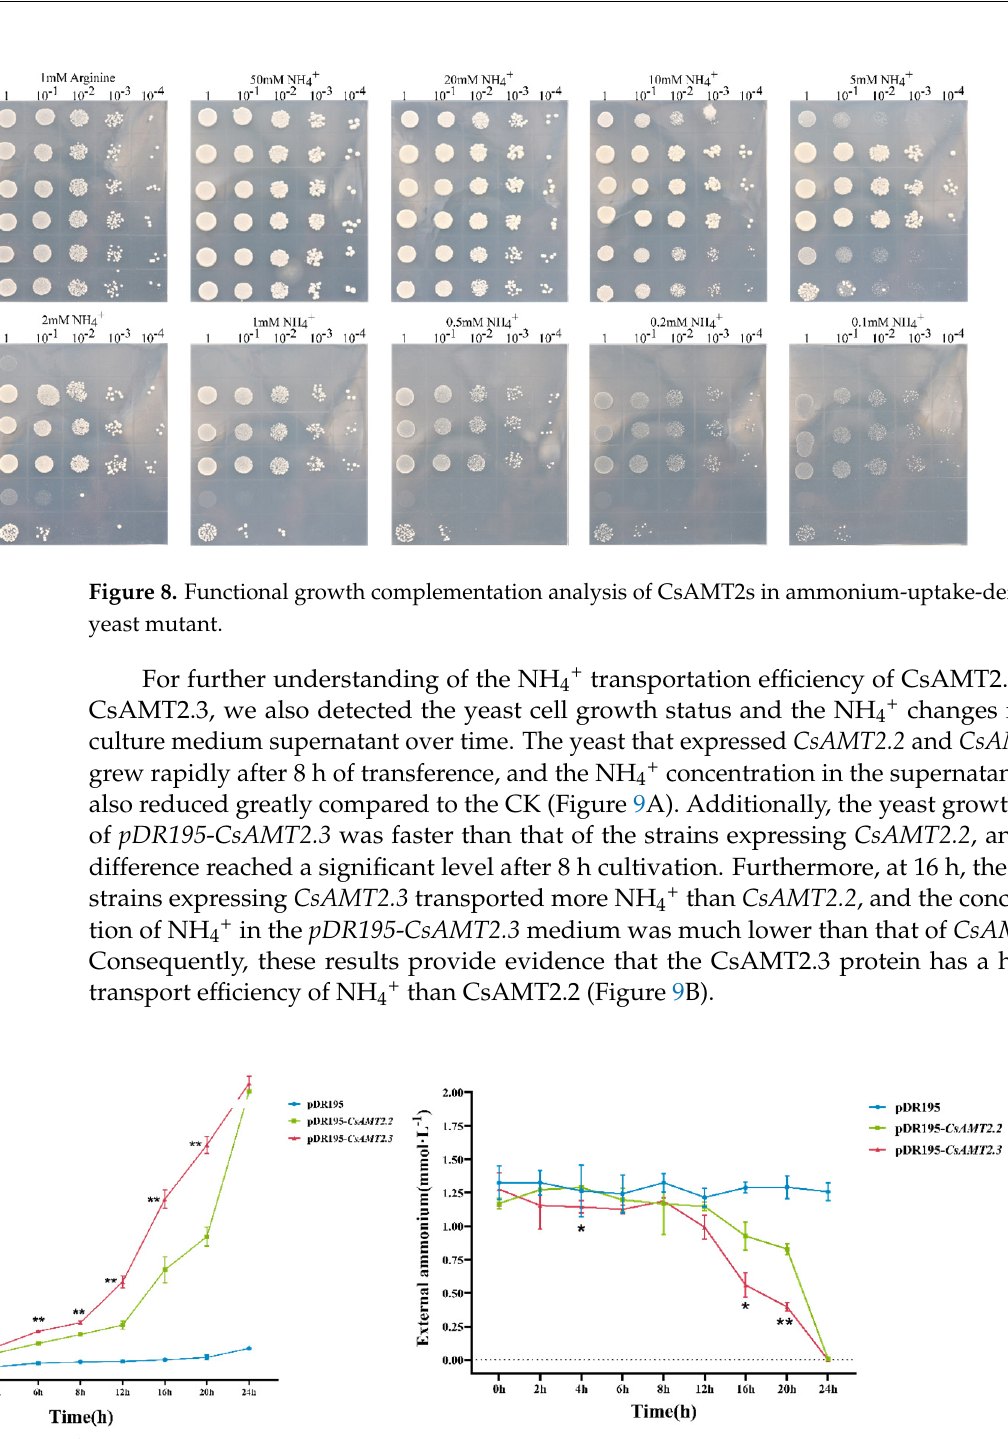
Figure 9. CsAMT2.2 and CsAMT2.3 mediates NH 4+ retrieval in 31019b yeast mutant strain. ( A ) The growth status (OD 600 changes) of each yeast strain over time. ( B ) The NH 4+ concentration changes in the supernatant of each yeast strain over time. Three biological replicates and three technological replicates were performed for each time point. The significance analyses of pDR195 - CsAMT2.2 and pDR195 - CsAMT2.3 were performed at each time point. * indicates that the difference is significant at the 0.05 level, and ** indicates the difference is significant at the 0.01 level.